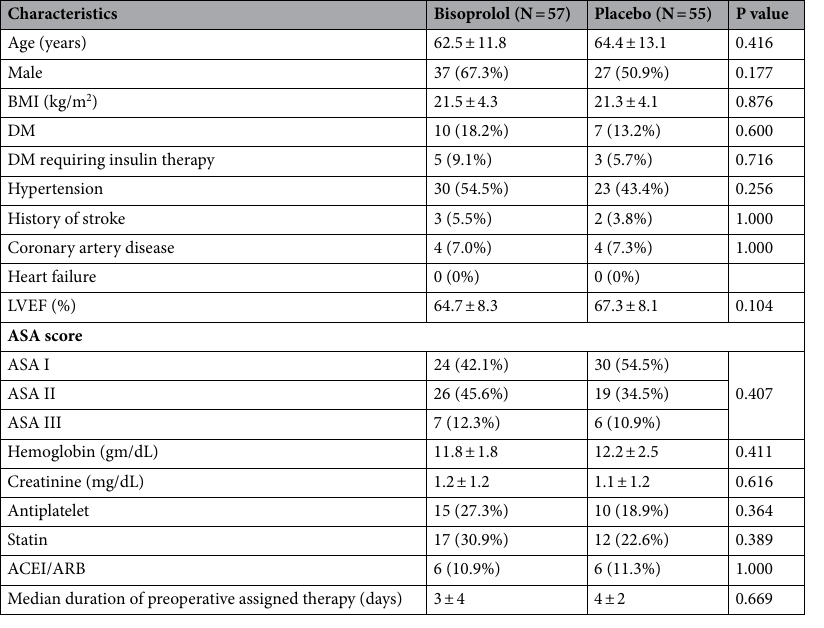
Table 1. Baseline characteristics between bisoprolol and placebo groups. ACEI/ARB angiotensin converting enzyme inhibitor/Angiotensin receptor blocker, BMI body mass index, DM diabetes mellitus, hs-TNT high- sensitive troponin-T, LVEF left ventricular ejection